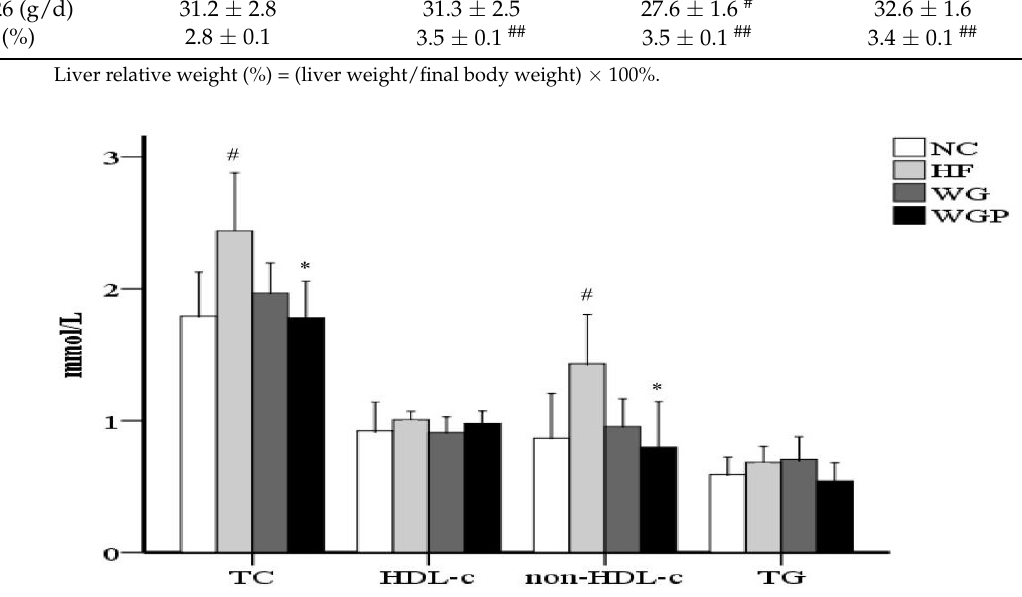
Figure 1. Wheat germ and wheat germ protein intake ameliorated the serum lipid profile in high-fat diet-induced rats. HDL-c, high-density lipoprotein cholesterol; non-HDL-c, non-HDL cholesterol; TG, triglycerides; TC, total cholesterol. Values are presented as means ± SEMs ( n = 5). # p < 0.05 vs. NC group. * p < 0.05 vs. HF group.